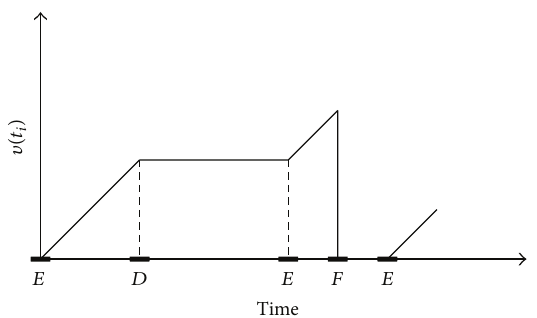
Figure 5: Time elapses, 𝑡 𝑖 is an interruptible transition.